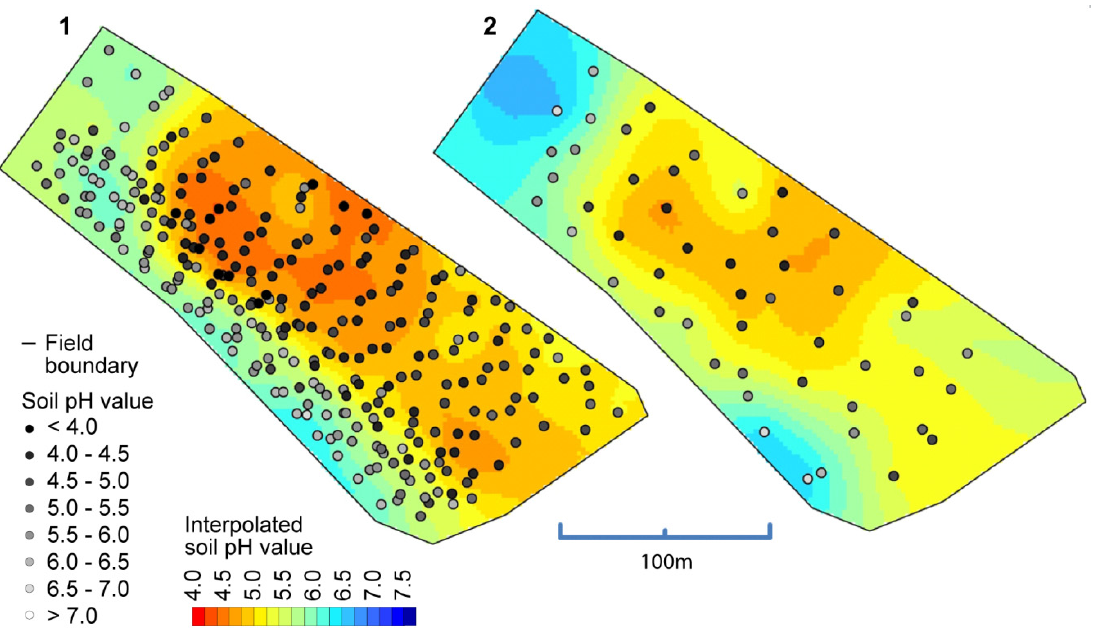
Figure 11. Soil pH map of field A computed from calibrated on-the-go sensor readings (1) and soil pH map computed from standard sampling and lab analysis (2).